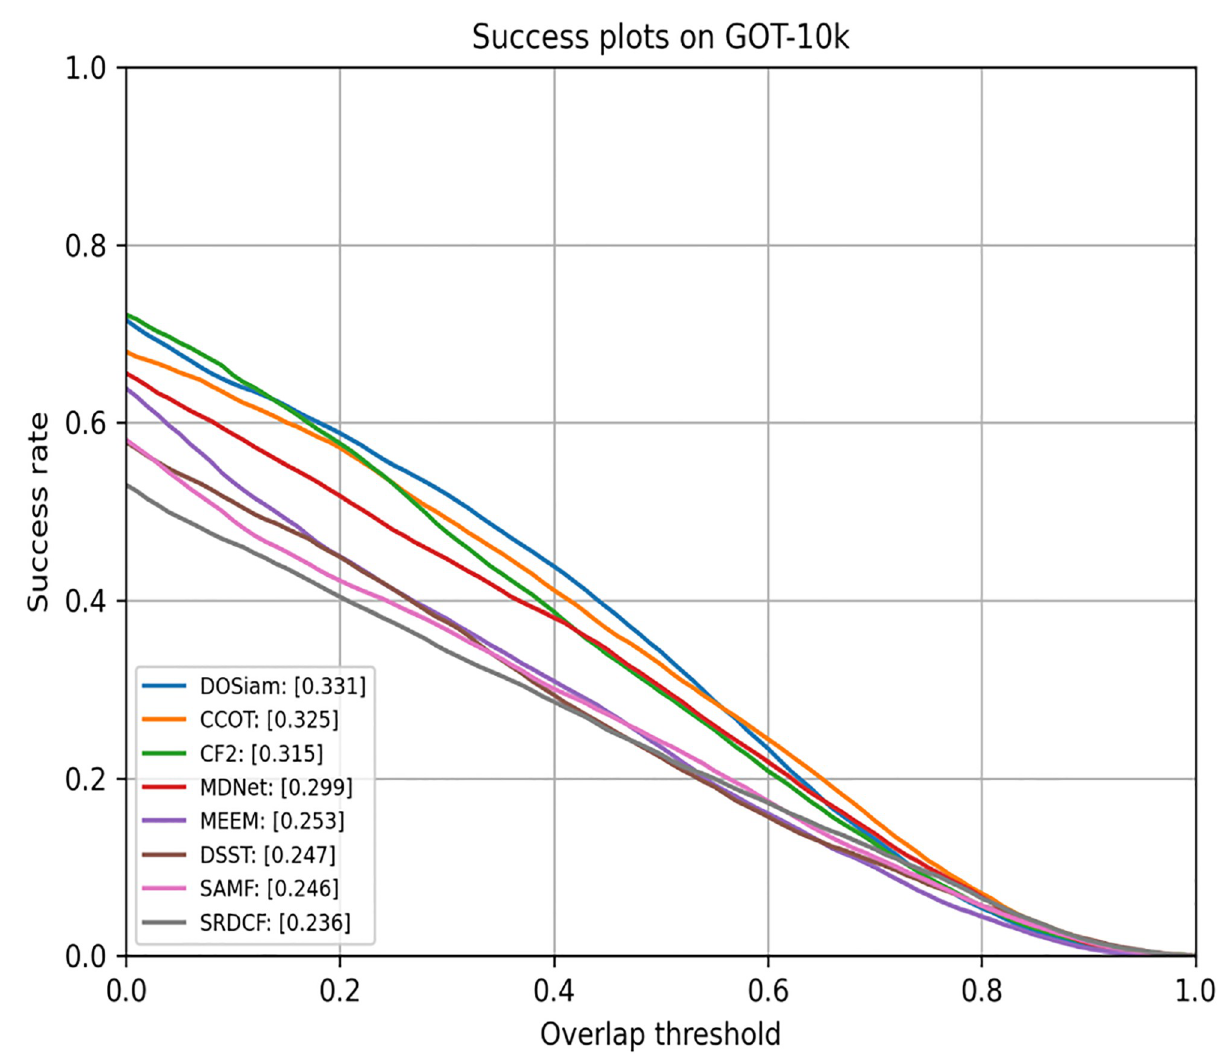
Fig 10. A comparison of the DOSiam with state-of-the-art trackers in GOT-10k.